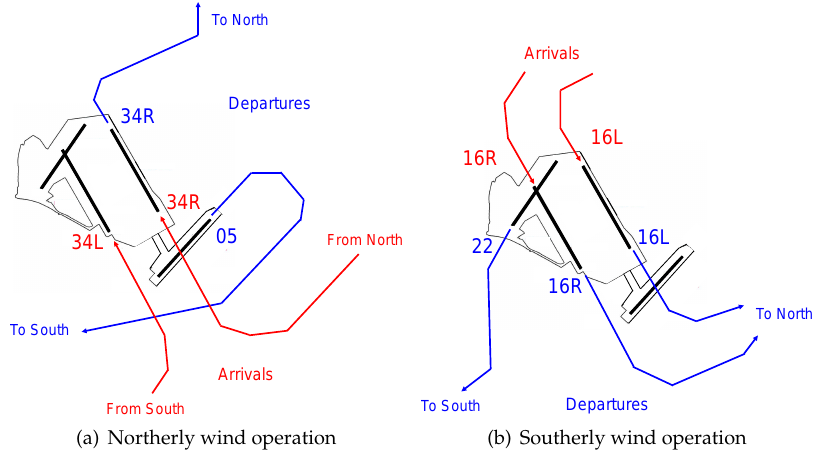
Figure 4. Runway configuration for departures ( blue lines ) and arrivals ( red lines ) at